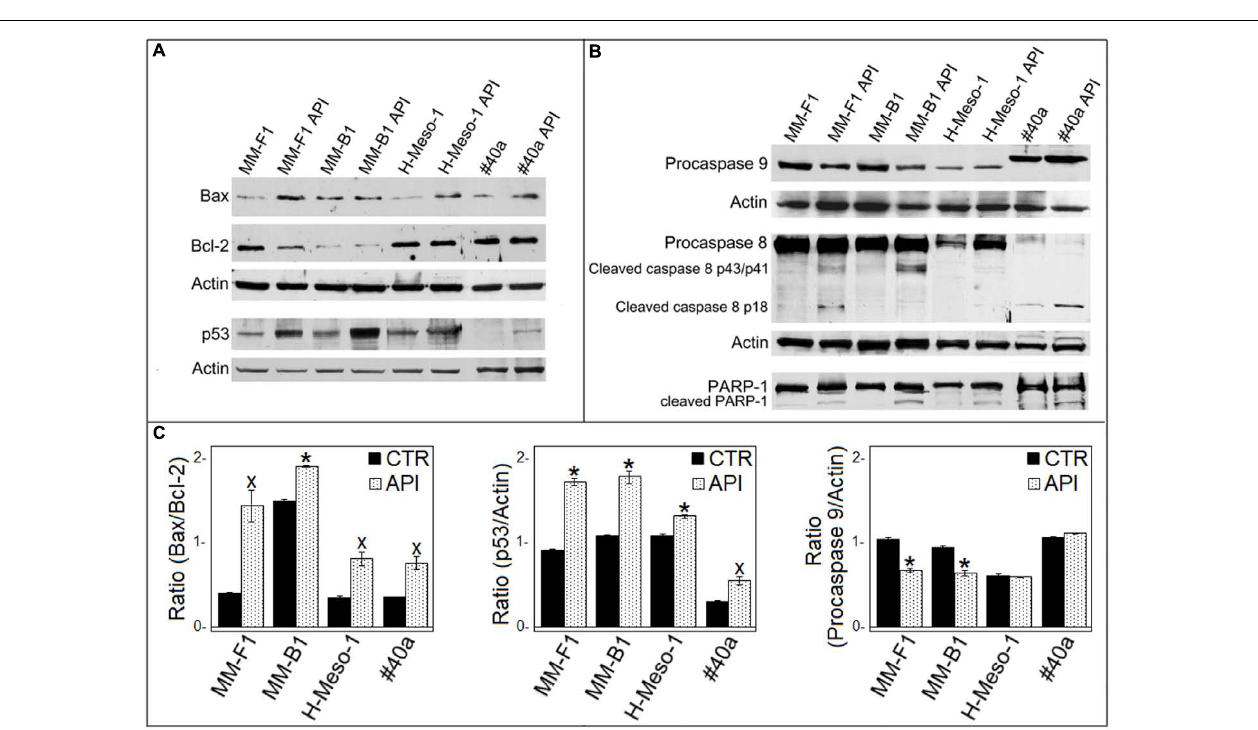
FIGURE 5 | Effect of API on the expression of molecules involved in apoptosis in MM cells. (A) The expression of Bax, Bcl-2, p53 was assessed by Western blotting analysis in MM cells treated for 24 h with API at 50 µ M or with DMSO (CTR) as vehicle. Actin was used as an internal control. (B) The expression of procaspase 9, procaspase 8, cleaved caspase 8 fragments, and the cleavage of PARP-1 were assessed by Western blotting analysis in MM cells treated for 24 h with API at 50 µ M or with DMSO (CTR) as vehicle. Actin was used as an internal control. The intensity of the bands was quantified using ImageJ software after blot scanning, obtained from two independent experiments. (C) The densitometric ratios between Bax and Bcl-2, between p53 and actin, and between procaspase 9 and actin and statistical analysis are reported. Data are expressed as the mean ± SD of two independent experiments ( x p ≤ 0.05, ∗ p ≤ 0.01 compared with